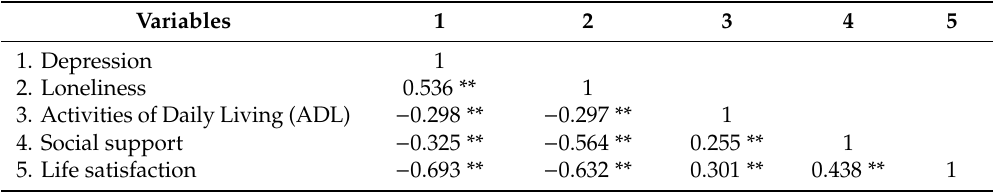
Table 4. Spearman’s correlation between variables (N = 609).